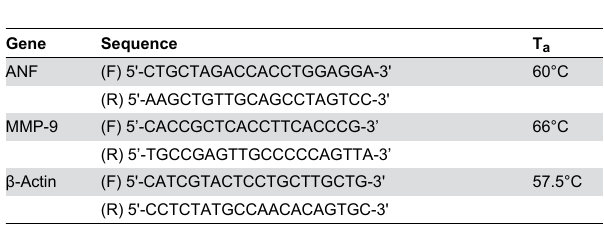
Table 1. Primers for